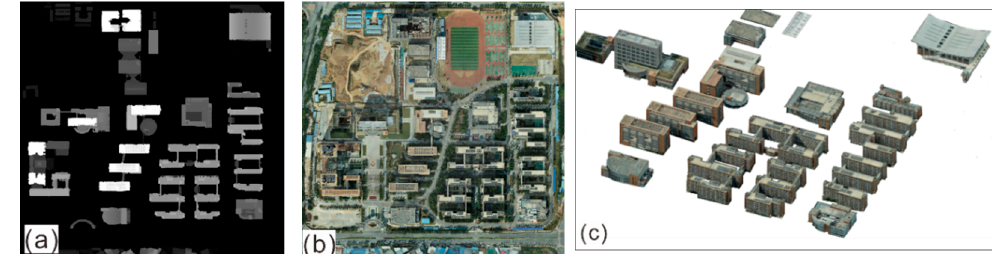
Figure 16. The experimental Dataset 2. ( a ) DTM data; ( b ) Aerial image data; ( c ) DBM data.